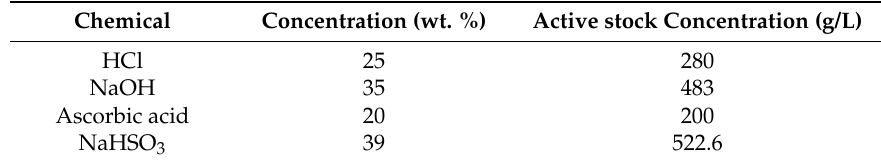
Table A5. Cleaning